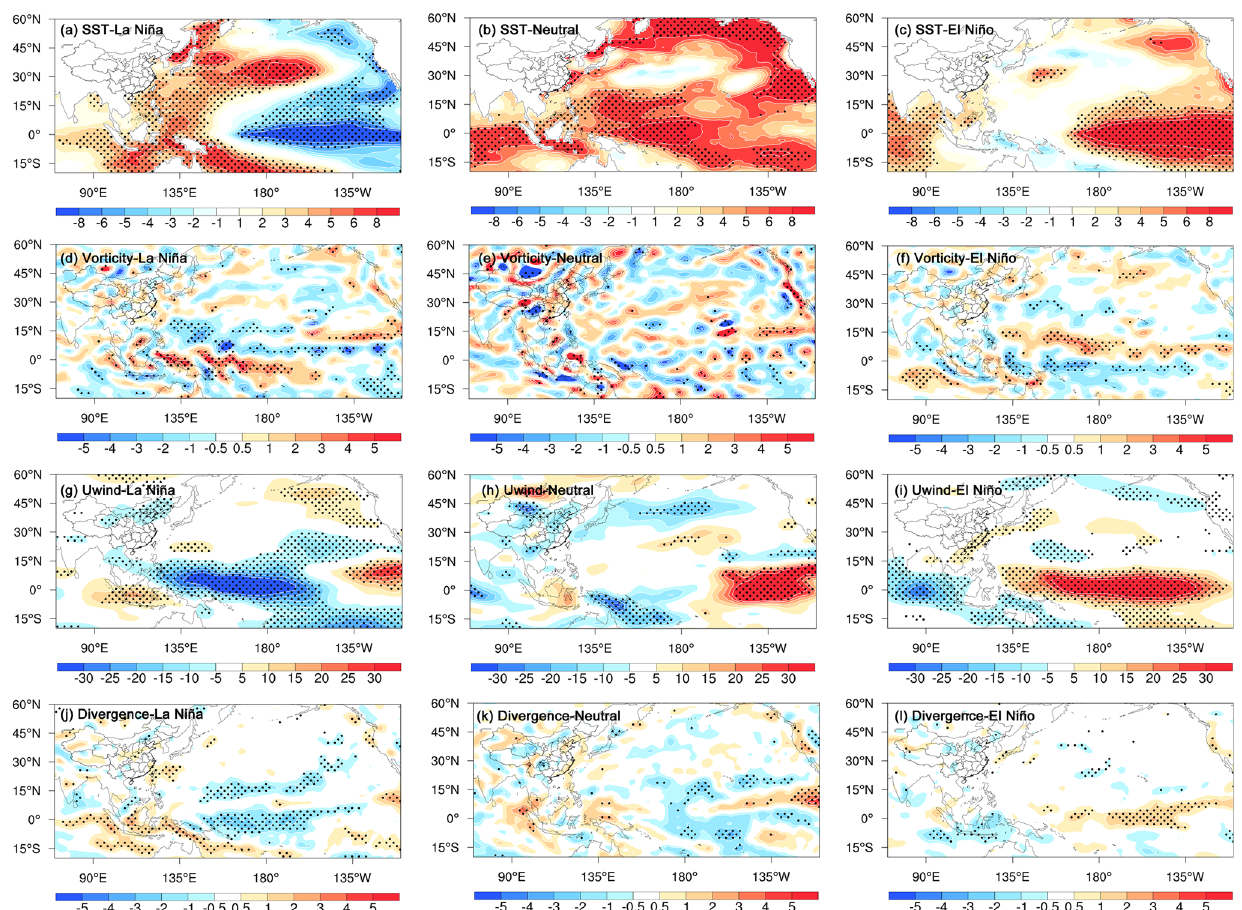
Fig. 11 Composited SST anomalies during La Nin˜a phase ( a ), neutral phase ( b ), and El Nin˜o phase ( c ), as well as low-level vorticity (1000-hPa) anomalies ( d )–( f ), zonal wind (850 hPa) anomalies ( g )–